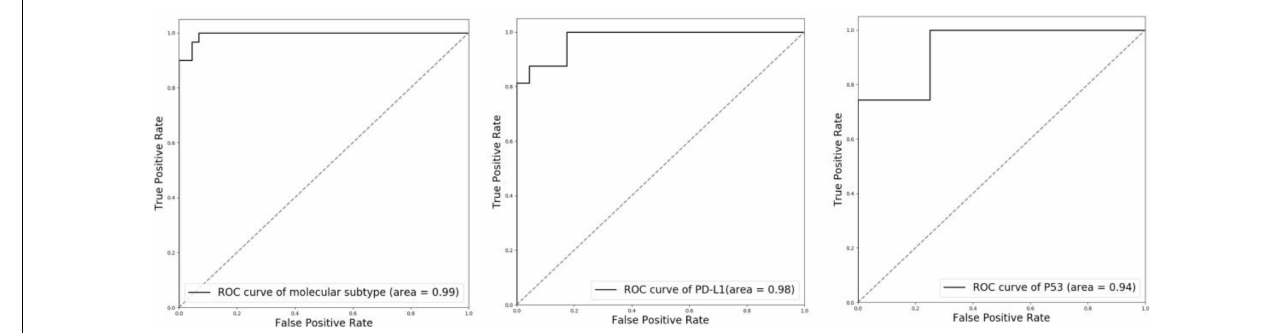
FIGURE 4 | ROC curves of molecular subtype, PD-L1 status, and p53 status with CNN recognition. Left: molecular subtype; Middle: PD-L1 status; Right: p53 status.